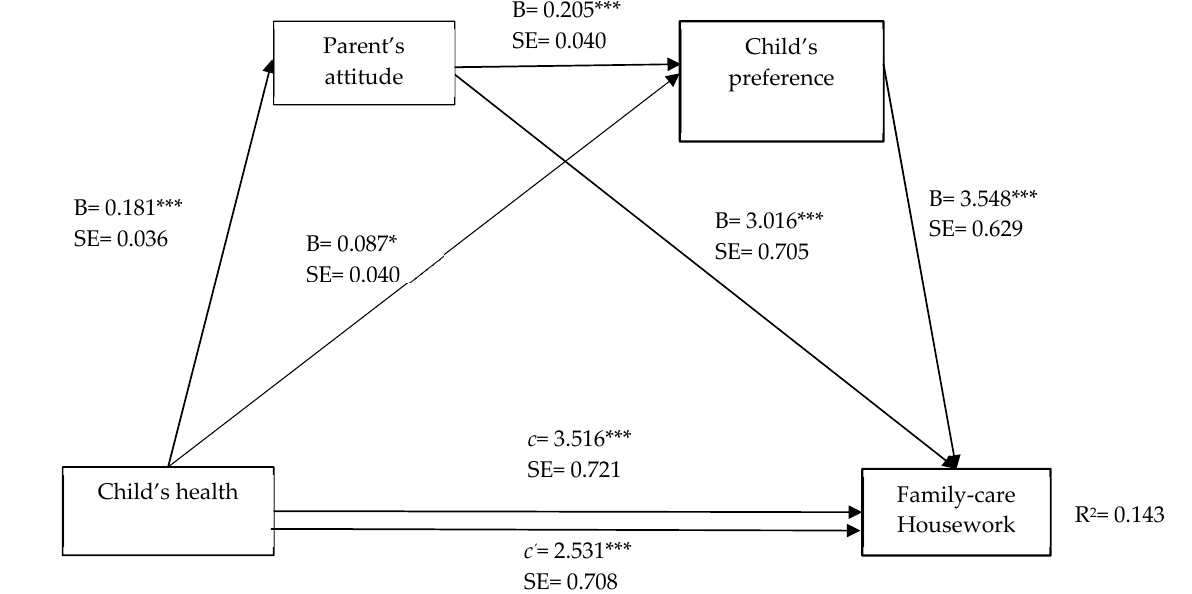
Figure 2. Serial multiple mediation of PACHP and Child’s housework preference in the relationship between Child’s health and family-care housework, with non-standardized beta values. *** p < 0.001,